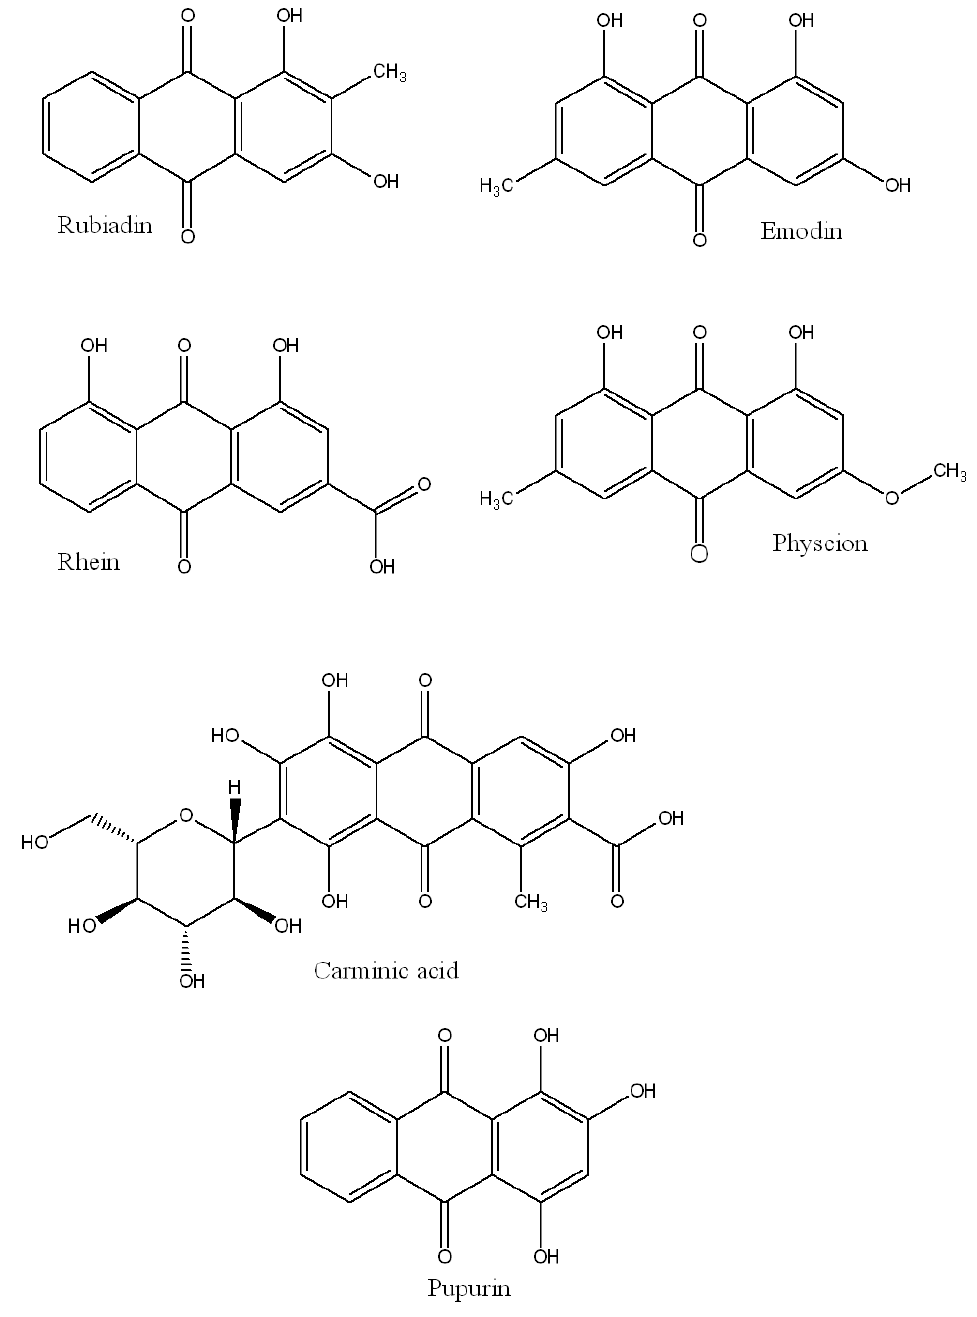
Figure 4. Chemical scaffold of anthraquinones.